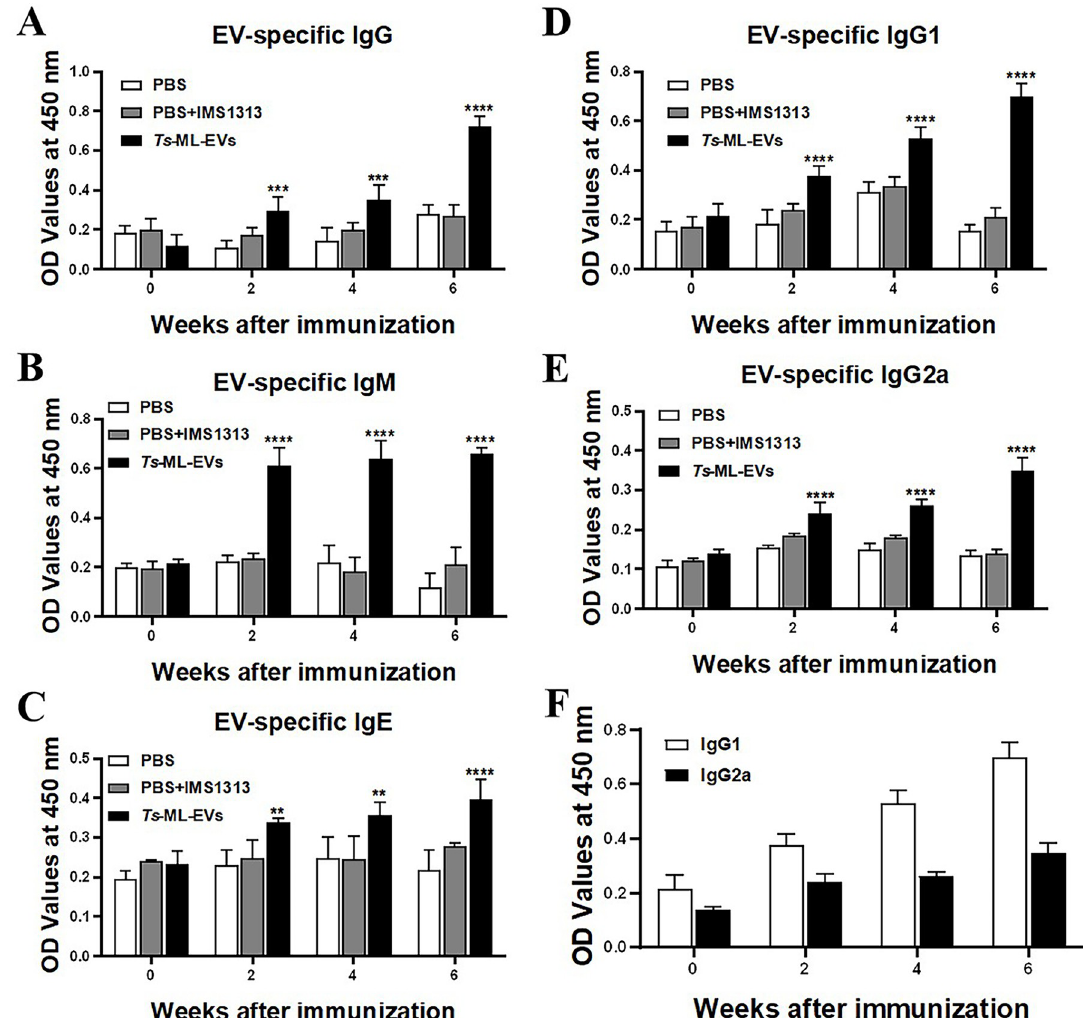
Fig 5. EV-sepecific antibodies detected from sera of immunized BALB/c mice. IgG (A), IgM (B), IgE (C), IgG1 (D) and IgG2a (E) antibodies against Ts -ML-EVs produced were analyzed by ELISA using sera (n = 8/group) from each group. (F) IgG subclass responses of mice immunized with Ts -ML-EVs were detected at different time points. Results represent the mean absorbance measured at 450nm from each group. Data were evaluated by Dunnett’s multiple comparison poet hoc test. All data are pooled from three independent experiments. � P < 0.05, �� P < 0.01, ��� P < 0.001, ���� P <